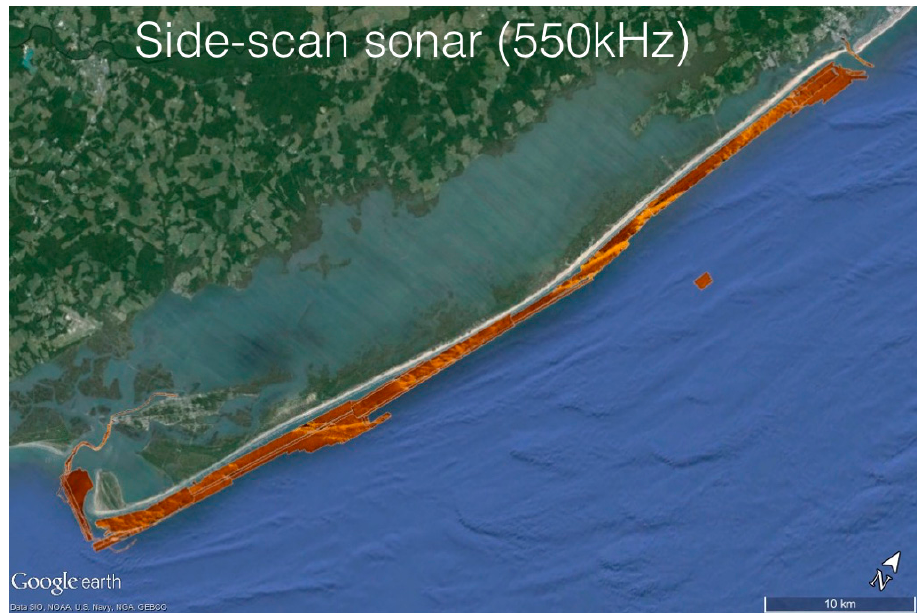
Figure 8. Side-scan mosaic from 2014–2015 acoustic surveys for the entire study area.